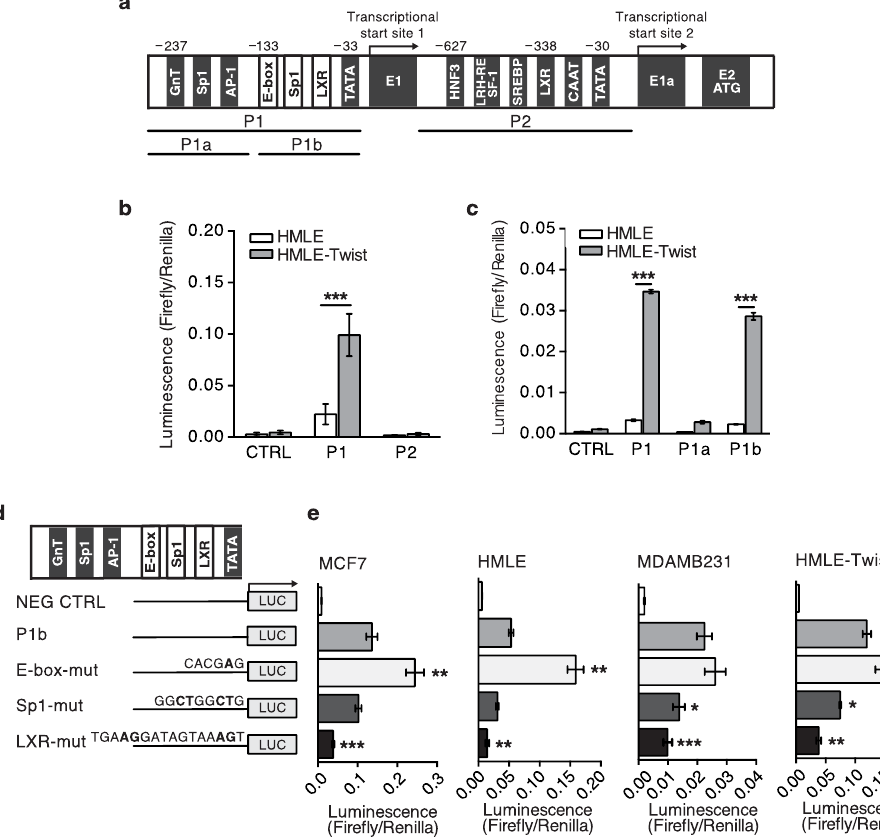
Figure 2. ABCA1 expression is differentially regulated in mesenchymal cell lines through the E-box motif in its proximal promoter. ( a ) This schematic outlines the structure of ABCA1 alternative promoters. ( b ) Luminescence induced by alternative proximal promoters P1 or P2 are shown on the y -axis ( n = 4 technical replicates). Error bars indicate one standard deviation. Statistical significance is indicated as in Figure 1. ( c ) Luminescence induced by promoter P1, or promoter fragments P1a and P1b, are shown on the y -axis ( n = 4 technical replicates). Error bars indicate one standard deviation. ( d ) This shows the mutations introduced to the P1b promoter fragment to disrupt binding capacity of the E-box, SP1, and LXR motifs. Mutations are labeled in bold. ( e ) Luminescence is shown on the x -axis for each of the mutant promoters in the MCF7, HMLE, MDA-MB-231, and HMLE-Twist cell lines ( n = 4 technical replicates, for each). Error bars indicate one standard deviation. At least three biological replicates were performed for each experiment, and representative data are shown. * p < 0.05, ** p < 0.01, *** p < 0.001.